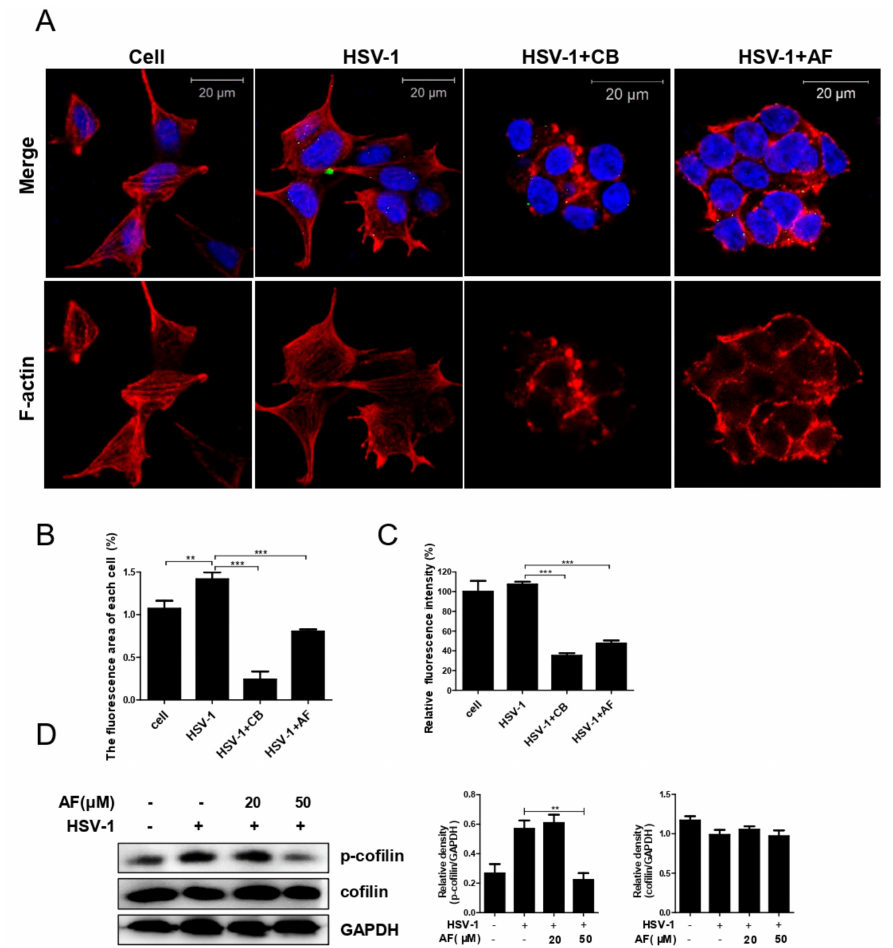
Figure 7. Amentoflavone disturbs cofilin-mediated F-actin assembly. SK-N-SH cells seeded in confocal dishes or six-well plates were infected with HSV-1 (MOI = 10) at 4 ◦ C for 2 h, and were treated with cytochalasin B (CB, 20 µ M), amentoflavone (50 µ M), or DMSO (cell and HSV-1 group) for 1 h at 37 ◦ C. ( A , B ) The cells were then stained with anti-VP5 primary antibody (green), TRITC-phalloidin (F-actin, red), and DAPI (nucleus, blue). ( B ) Image J software was used to analyze the percent of F-actin fluorescence area of each cell in images (50 cells). Data are mean ± SD ( n = 3). ** p < 0.01, *** p < 0.001. ( C ) F-actin was stained with TRITC-phalloidin and was analyzed by flow cytometry (Becton Dickinson). Data are mean ± SD ( n = 3). *** p < 0.001. ( D ) After HSV-1 attachment at 4 ◦ C for 2 h, SK-N-SH cells were shifted to 37 ◦ C for 1 h in the presence of amentoflavone or DMSO. The protein levels of total or phosphorylated cofilin were detected by western blot. Data are mean ± SD ( n = 3). ** p <